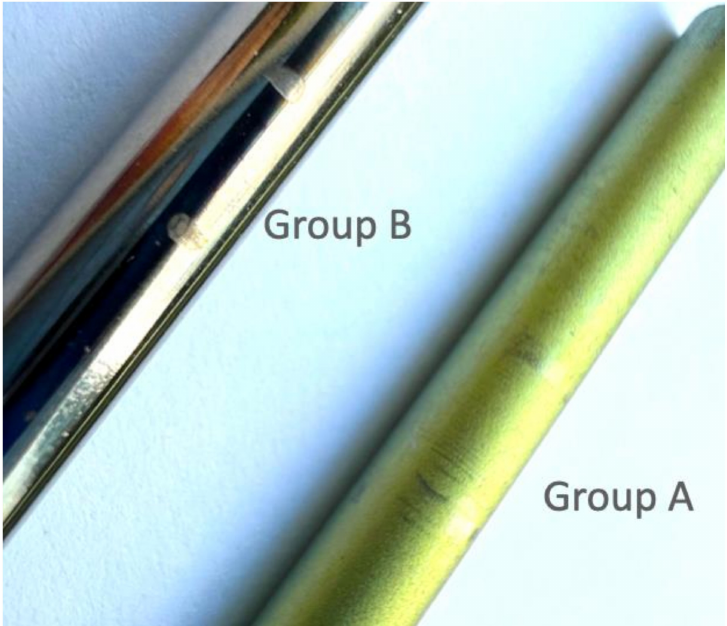
Figure 5. The contact surface between the set screw and Ti6Al4V rod in Groups A and B after tightening the tulip head of the pedicle